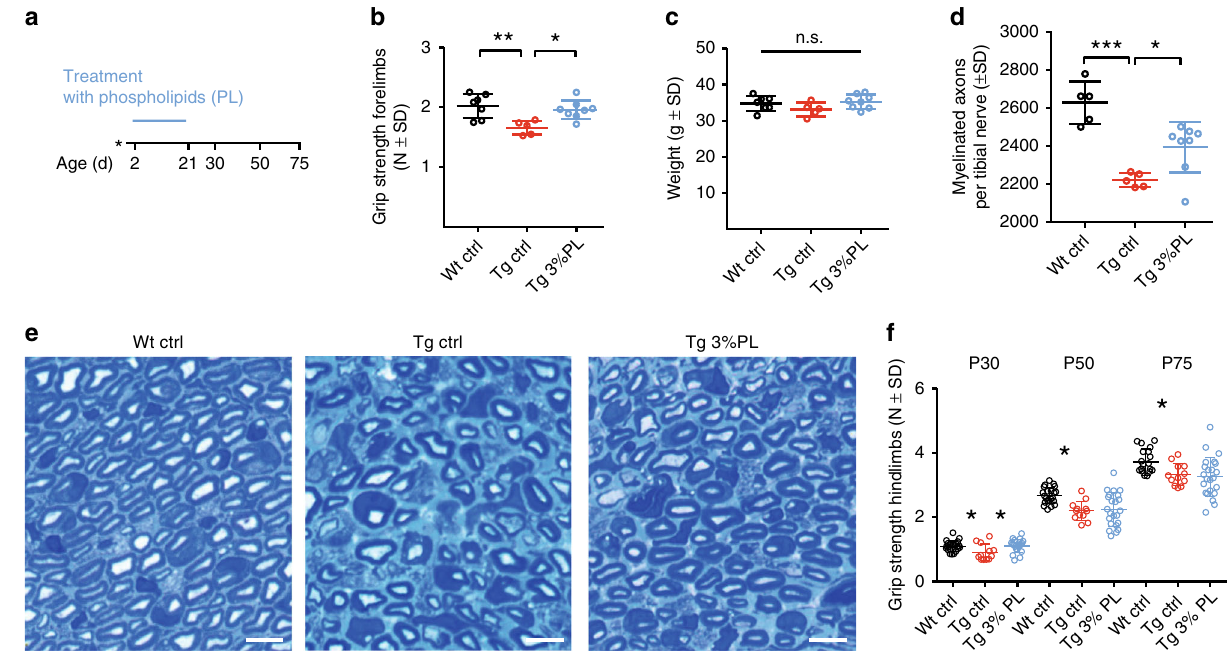
Fig. 6 Early phospholipid therapy ameliorates neuropathy in CMT rats. a CMT rats were fed with either normal diet or a food enriched with 3% phospholipids (PL, see Methods section for details) from postnatal day (P) 2 to P21 (early short term, Figs. 6b – f, 7a) and analyzed at P21 ( b – e ) or at P30, P50, and P75 ( f ). b , c One cohort of early short-term-treated rats was analyzed at P21. Tg ctrl rats (red, n = 5) display a reduced grip strength ( b ) compared with Wt controls (black, n = 7). Treatment with 3% PL from P2 to P21 improves grip strength in CMT rats (blue, n = 8) (left panel). Body weight measurement reveals no overall difference ( c ). One-way ANOVA, Sidak ’ s post test. d , e Light microscopic examples ( e ) and quanti fi cation ( d ) of the number of myelinated fi bers per tibial nerve cross section at P21. CMT rats (red, n = 5) display less myelinated fi bers when compared to Wt controls (black, n = 5). Treatment of CMT rats with 3% PL (blue, n = 8) signi fi cantly improves the number of myelinated fi bers (one-way ANOVA, Tukey ’ s post test, scale = 10 µ m). f A second cohort of rats treated with the early short-term paradigm (P2 – P21) was analyzed for grip strength at P30, P50, and P75. Whereas the treatment effect was still visible at P30, no effect could be seen anymore at P50 and P75 (Wt ctrl, black, n = 22; Tg ctrl, red, n = 12; Tg 3% PL, blue, n = 21). One-way ANOVA, Tukey ’ s post test, p value: *<0.05, **<0.01, ***<0.001, n.s., not signi fi